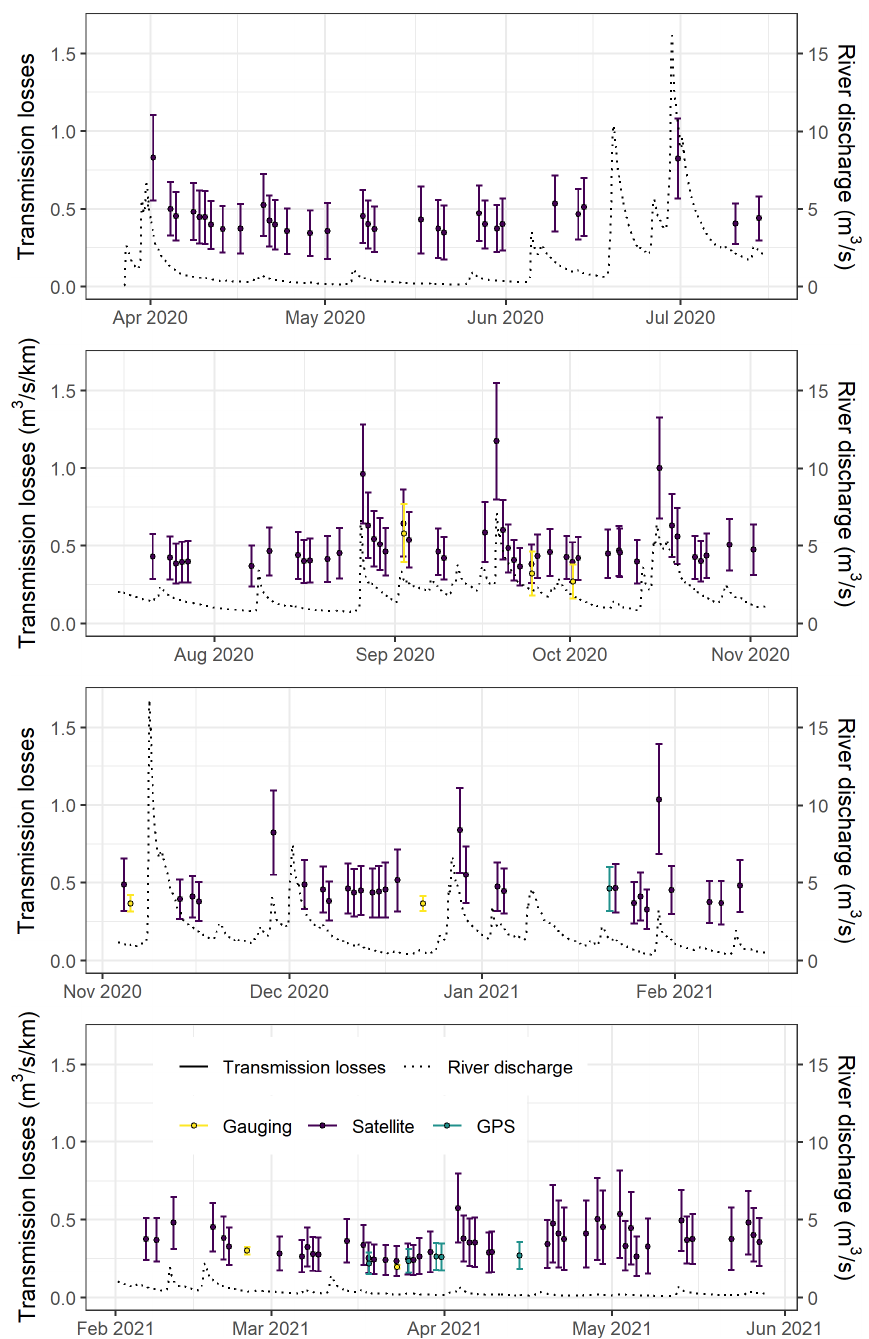
Figure 9. Time series of the river discharge (black dotted line) and transmission losses (error bars) estimated using the differential gauging (“Gauging”, yellow) and the river drying front methods with field GPS measurements (“GPS”, blue green) and satellite imagery (“Satellite”,